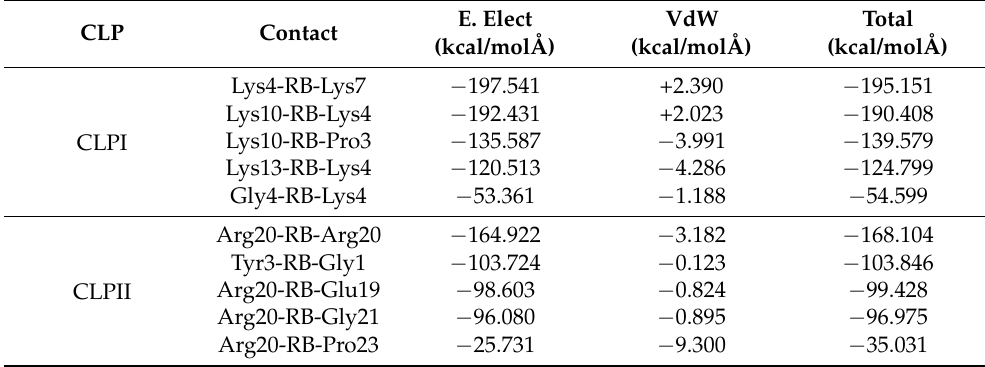
Table 1. Energy evaluation of CLP-RB-CLP ternary complexes interaction formed during molecular dynamics